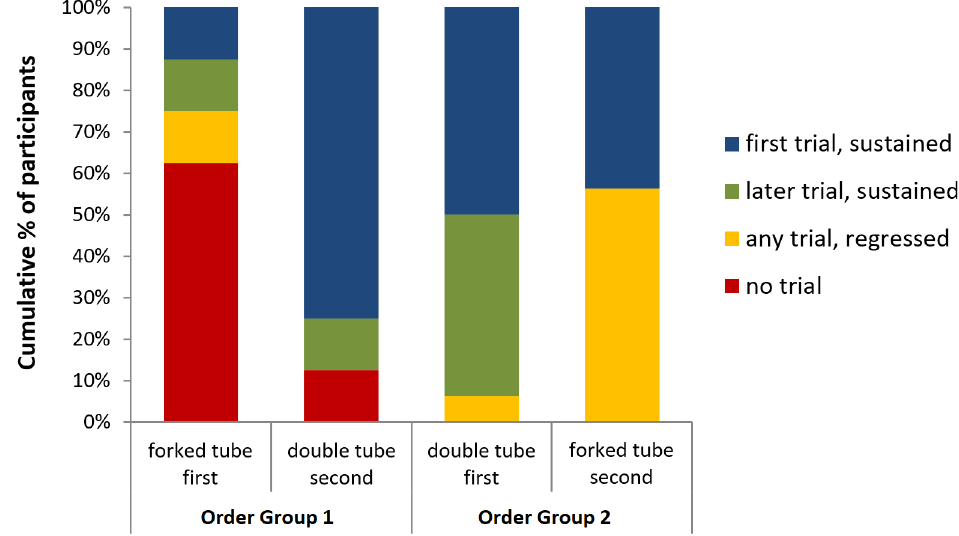
Fig 3. Cumulative percentages of 2.5-year-olds categorised according to when they covered two exits across all 12 trials of the forked and double tube tasks. The first two bars represent the group of children who completed the forked tube task first, whereas the second two bars represent the group of children who completed the double tube task first. See the coding section for detailed category definitions.